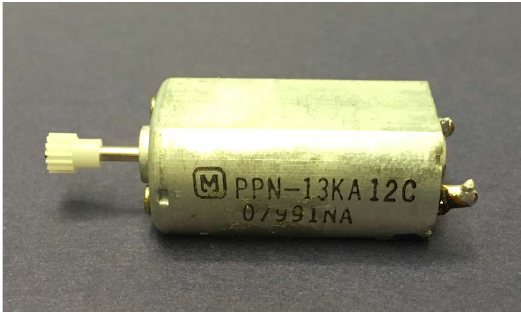
Figure 1. Photo of the mini DC